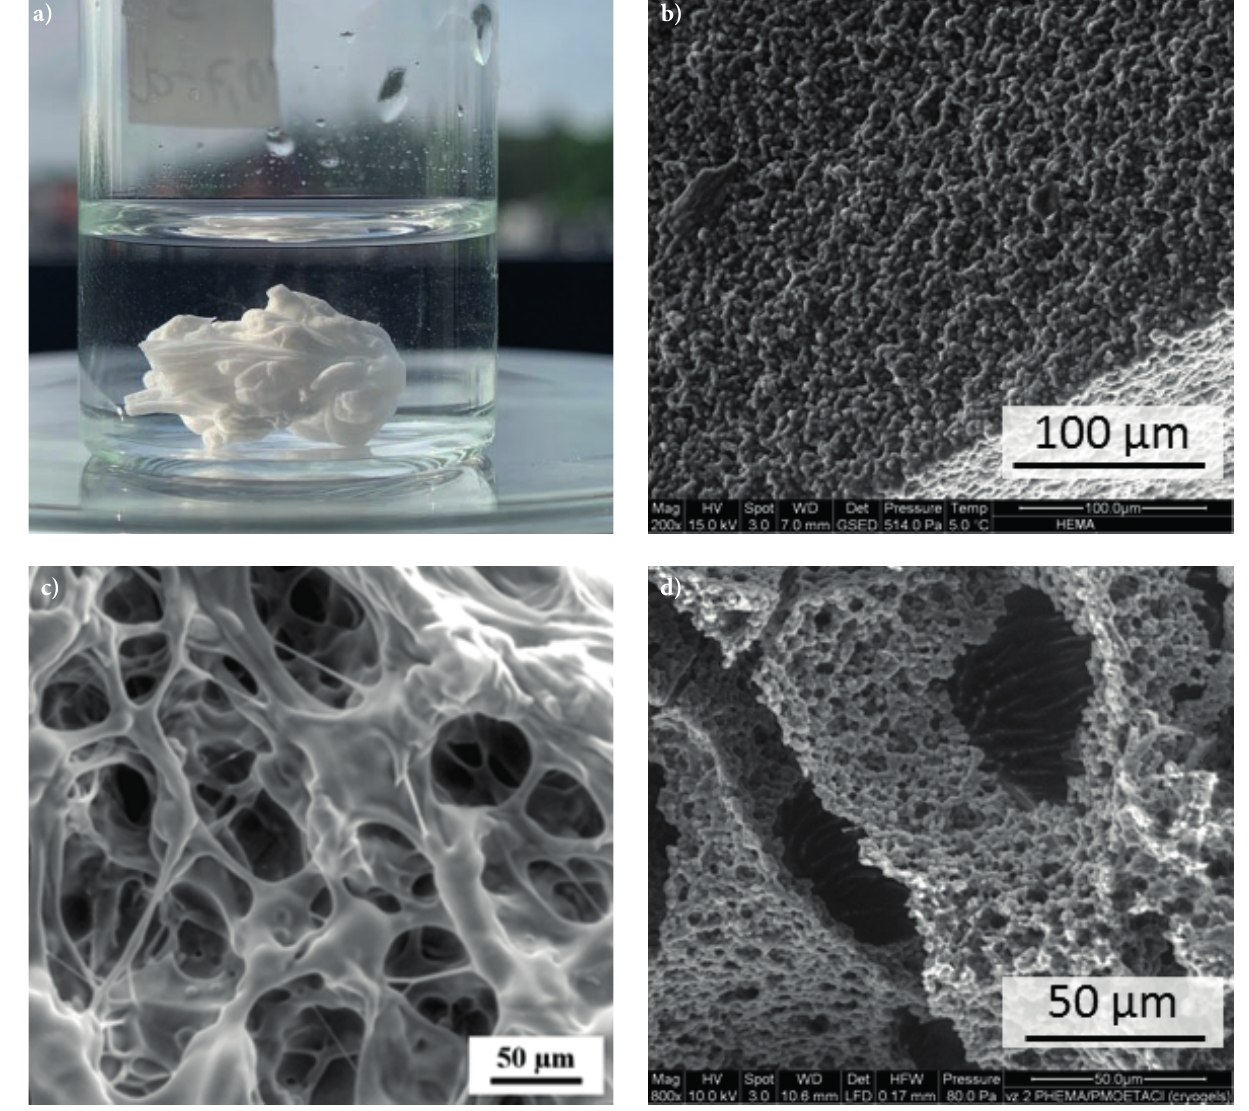
Figure 5. Porous hydrogels prepared from poly(2hydroxyethyl methacrylate) and visualized by the methods of scanning electron micros- copy. (a) Macroscopic view; (b) PHEMA hydrogel showing after the microsyneresis a structure of connected spheres, (c) PHEMA hydrogel prepared from poly(HEMA- stat -MA) (fractionated NaCl was used as a porogen; after washing out the porogen, the gel was visualized by the AquaSEM method); (d) microscopic structure of a cryogel of HEMA showing the dual size of pores. Figs 5b and 5d were obtained by the so-called environmental SEM.